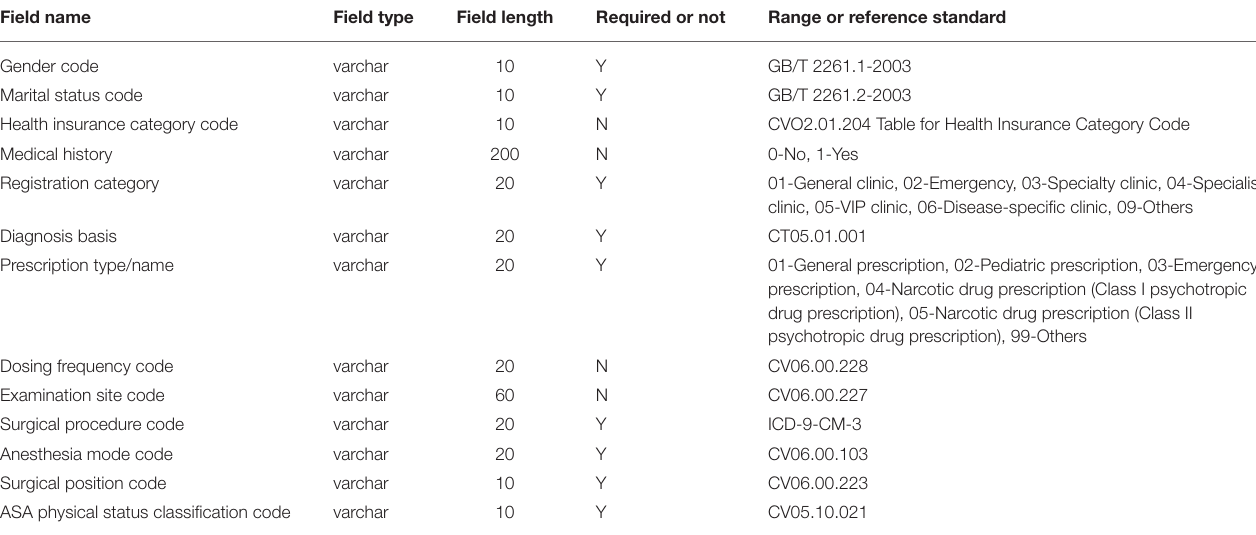
CVO2.01.204 Table for Health Insurance Category Code